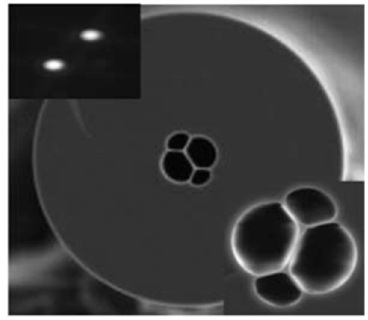
Figure 19. A fiber loop mirror configuration is formed using this suspended twin-core fiber for torsion measurement (Reproduced from [81], with the permission of OSA publishing).